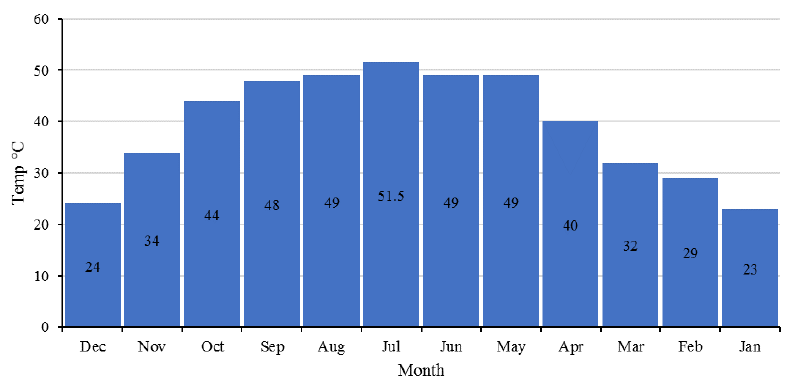
Figure 10. Daily temperature in Ahvaz [80].